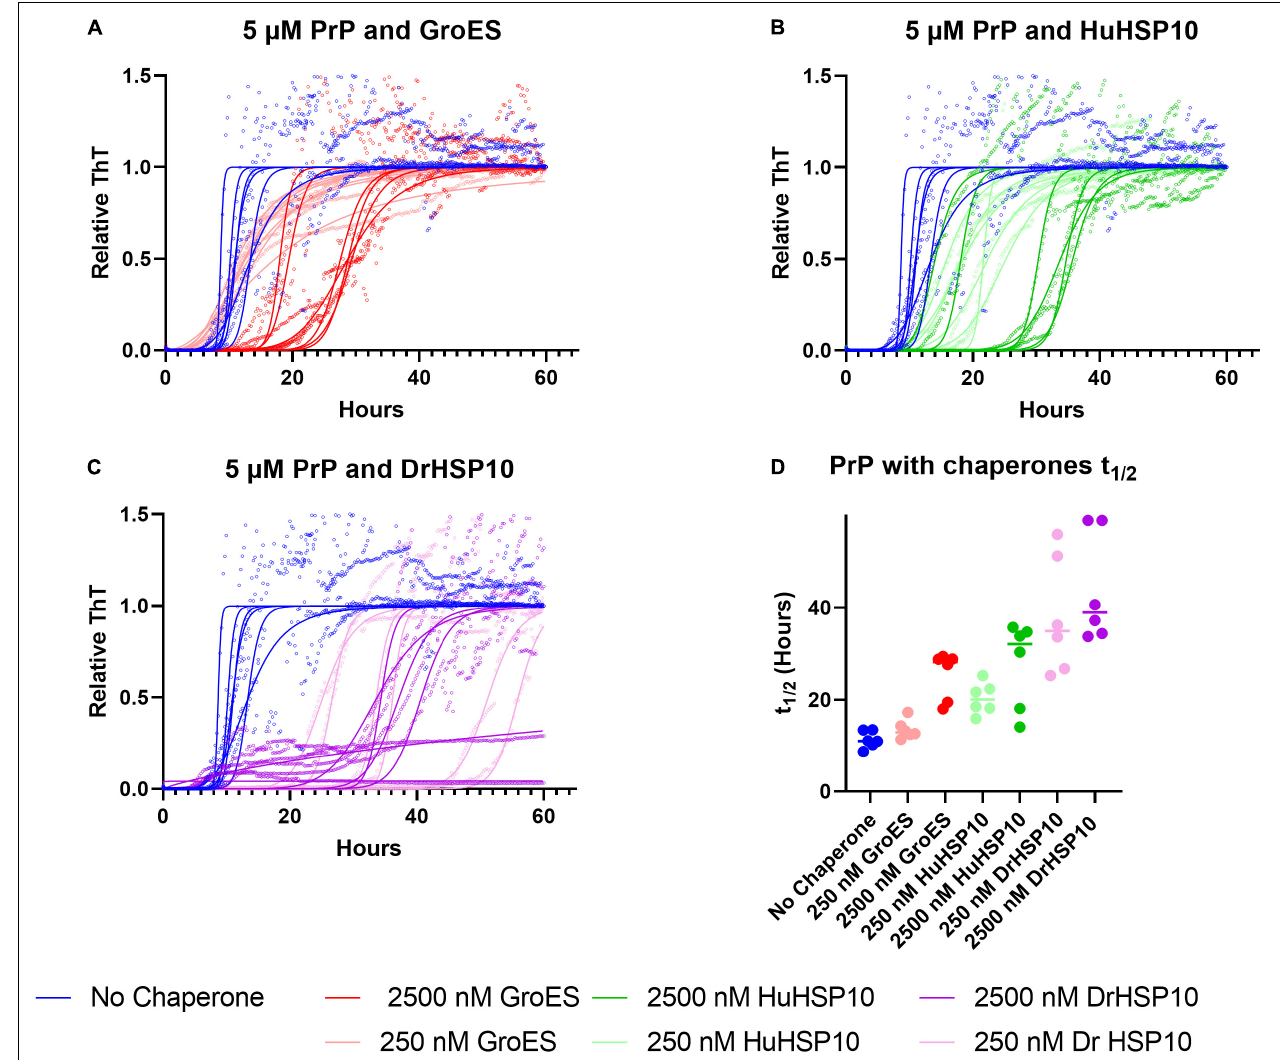
FIGURE 9 | PrP fibrillated in the absence (denoted in blue) and presence of HSP10 chaperones. (A) GroES (denoted in red) and PrP, (B) HuHSP10 (denoted in green) and PrP, and (C) DrHSP10 (denoted in magenta) and PrP. The assay was conducted with shaking at 37 ◦ C in a non-treated 96-well plate. Concentrations during fibrillation: HuPrP90–231: 5 µ M, chaperones: 2.5 or 0.25 µ M. (D) Half-time of conversion (t 1 / 2 in hours) in the absence and presence of the different chaperones. The plot illustrates concentration dependence and different activities in mitigating PrP fibrillation, showing the following order of effectiveness: DrHSP10 > HuHSP10 >